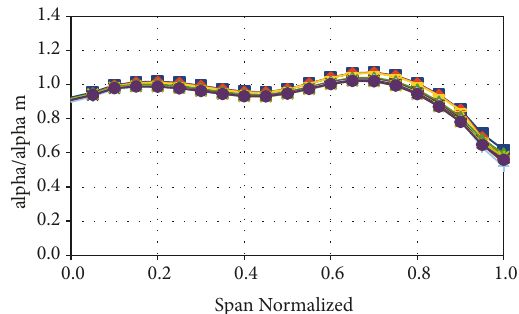
Figure 12: Flow angle/mean flow angle vs span at rotor inlet section for different rotational speed, full admission.